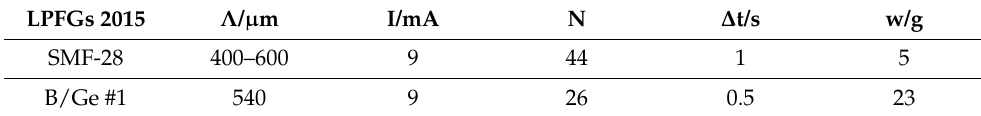
Table 1. Fabrication parameters of the LPFGs from 2015.